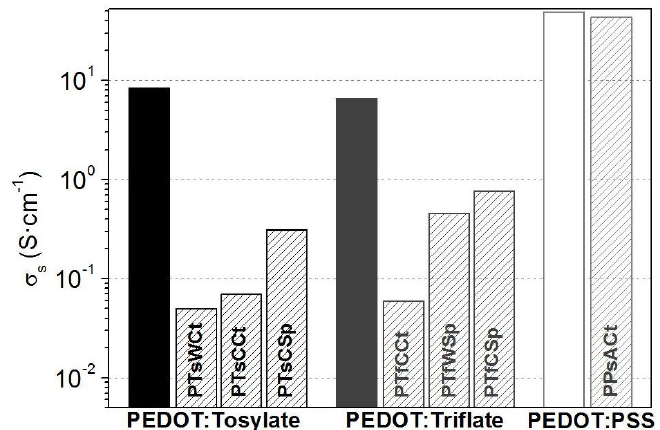
Figure 4. σ s values of raw CPs (solid bars) and selected composite materials (patterned bars).